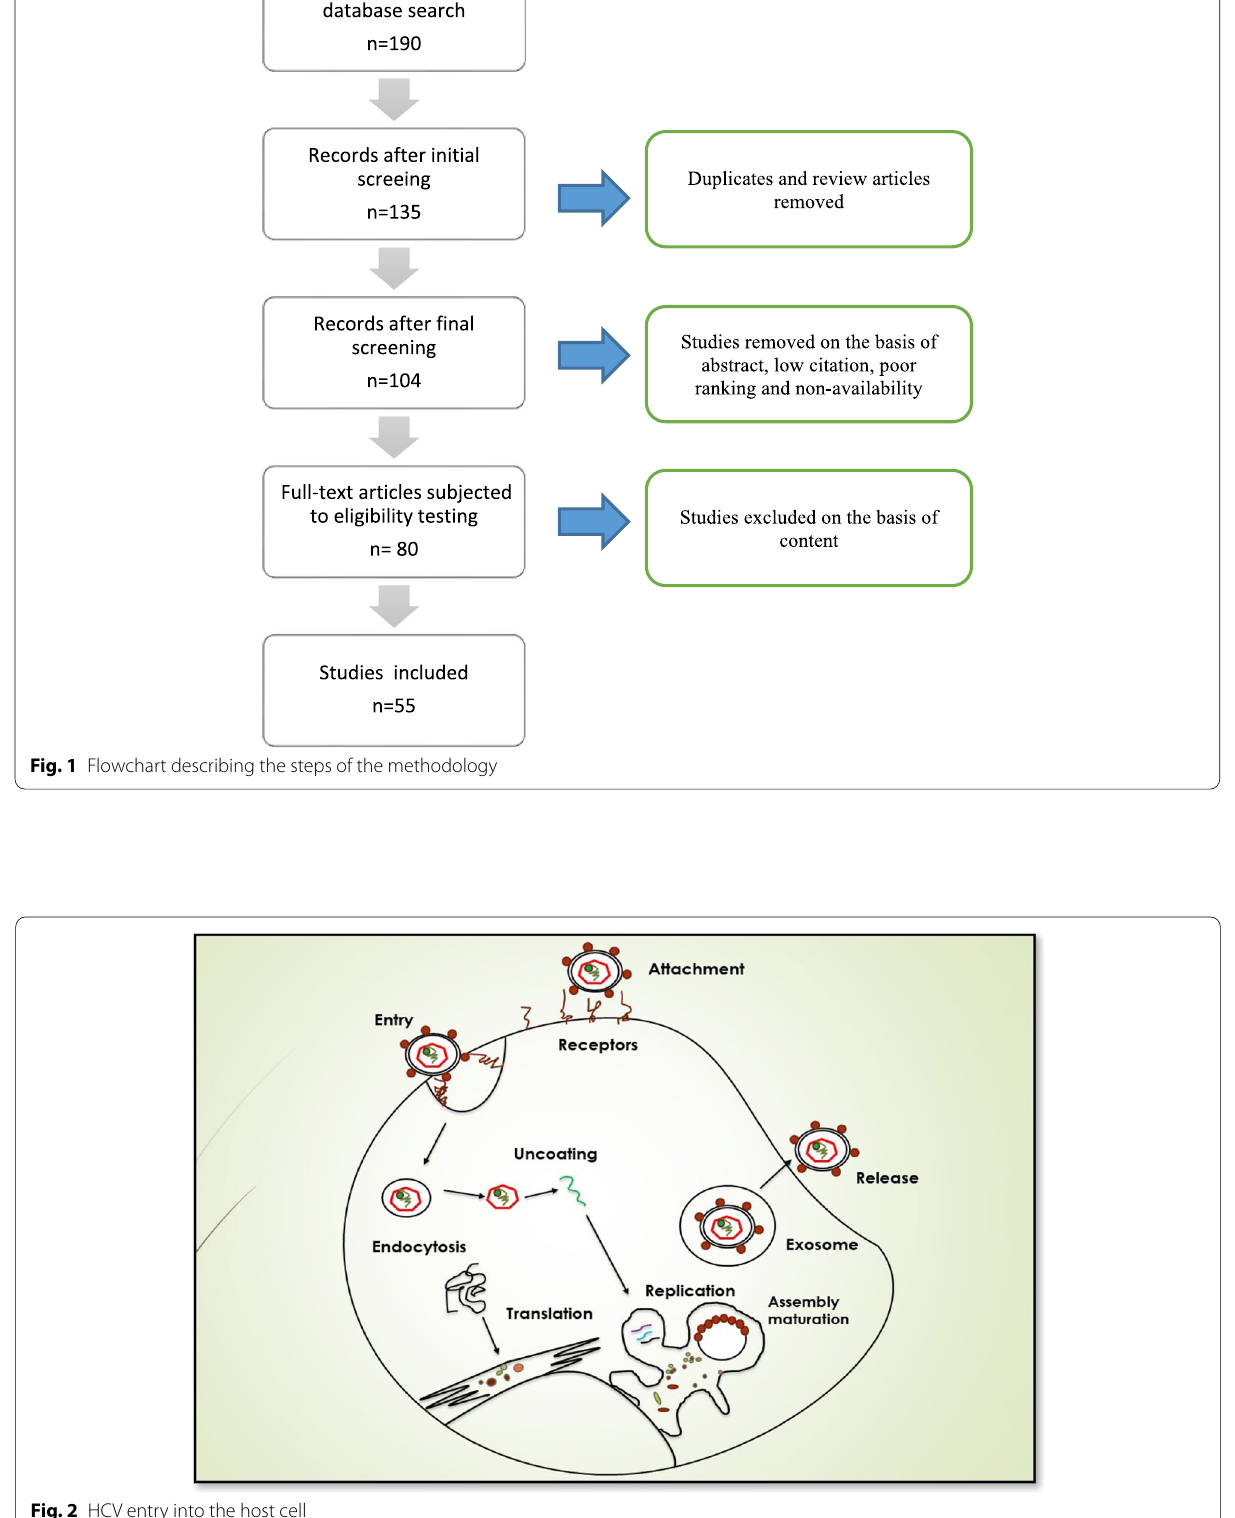
Fig. 2 HCV entry into the host